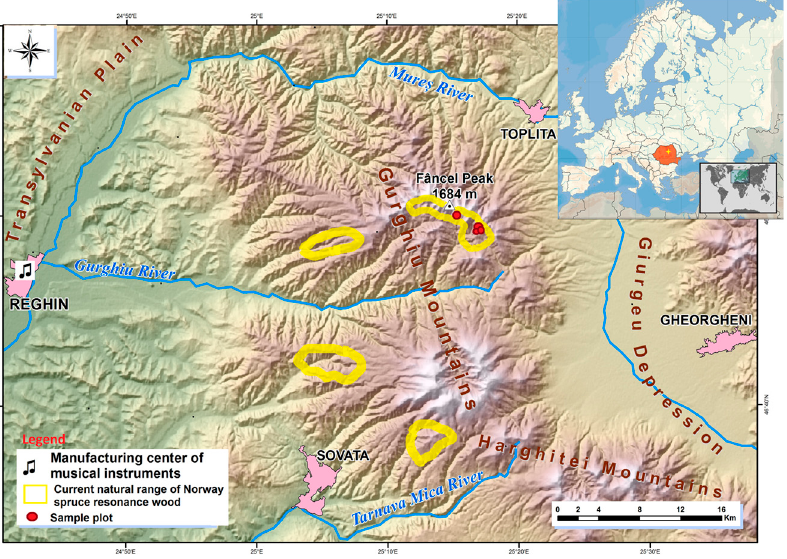
Figure 1. Location of the sampled resource of resonance spruce wood.